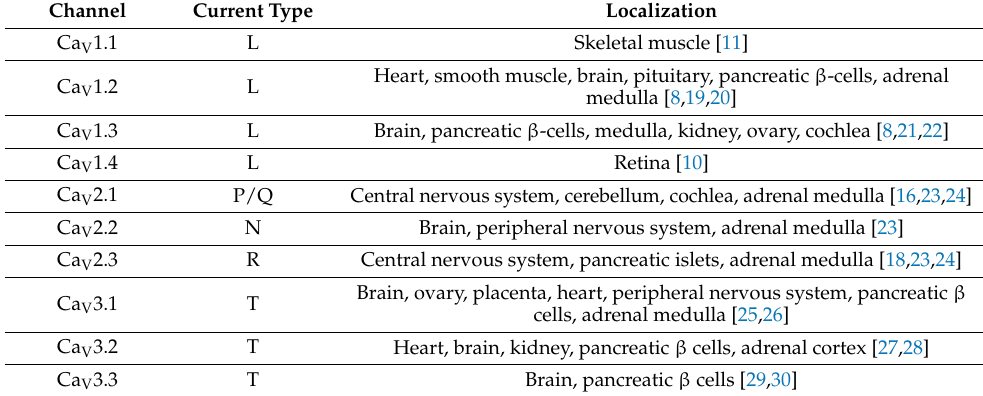
Table 1. Localization of voltage-gated calcium channel